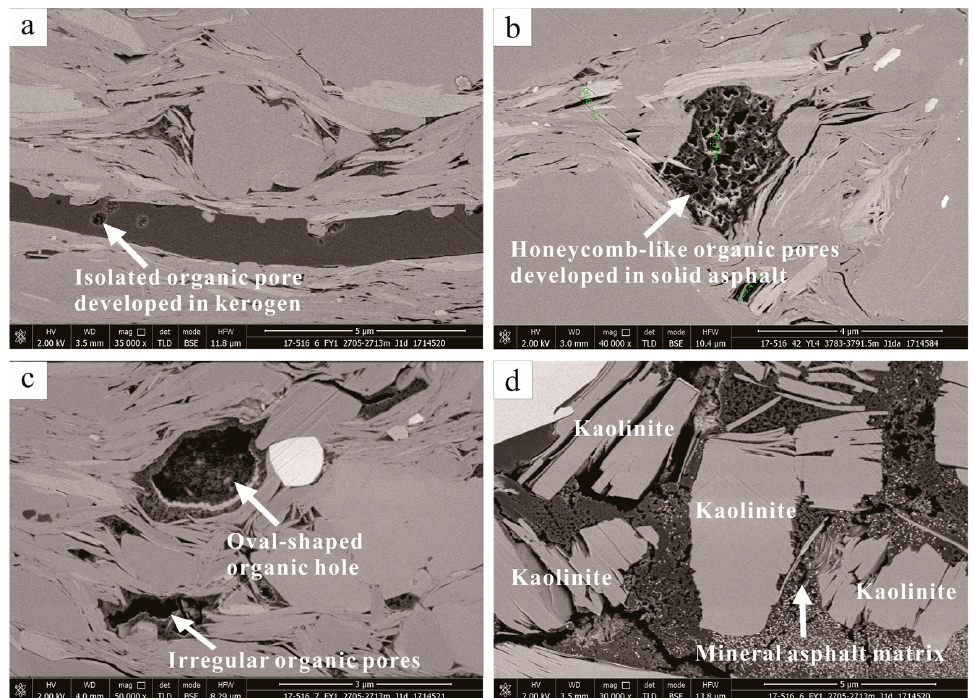
Figure 5. Scanning electron microscopic characteristics of organic pore development in Da’anzhai shale. ( a ) Organic pores in kerogen, Well FY1, 2705 m, Da’anzhai section. ( b ) Honeycomb organic pores in solid bitumen, Well YL4, 3783 m, Da’anzhai section. ( c ) Elliptical and irregular organic pores in solid bitumen, Well FY1, 2705 m, Da’anzhai section. ( d ) Organic pores in mineral bitumen matrix, Well FY1, 2705 m, Da’anzhai section.